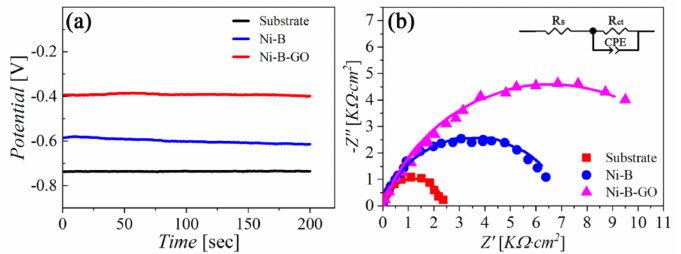
Figure 10. ( a ) OCPT curves and ( b ) Nyquist plots for the substrate, Ni − B coating, and Ni − B − GO coating in 3.5 wt% NaCl solution.